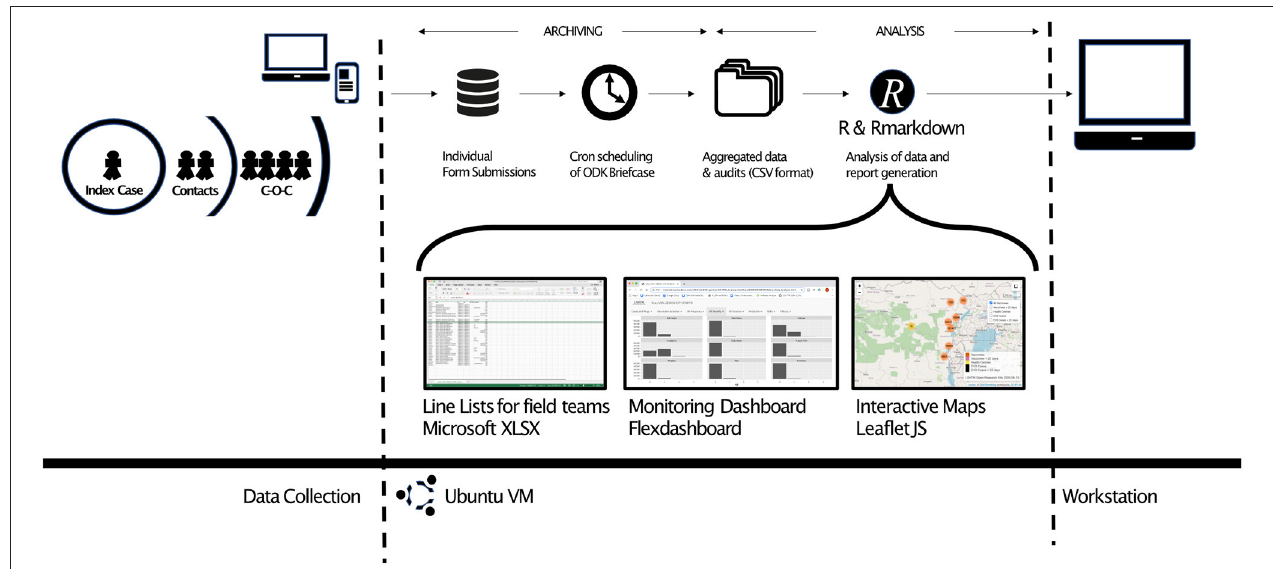
FIGURE 3 | Fully customizable automated data flows. The time-based scheduler cron calls ODK Briefcase to perform data archiving and parsing of data from individual forms to aggregated tables of data in comma separated variable (CSV) format. Cron calls to R control R markdown documents that perform statistical, geospatial and demographic analysis, along with data manipulation to create line lists, audit documentation, interactive monitoring dashboards (based on open tools such as Flexdashboard, LeafletJS, etc), interactive maps and other outputs that are shared to workstations of partners in the field, senior academic team, and internal/external